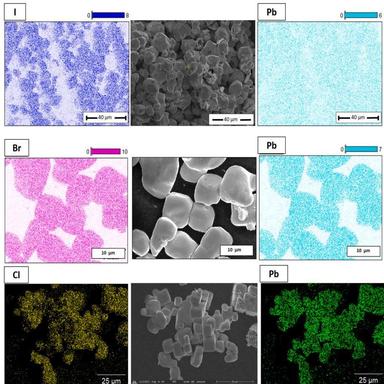
The dark field images of powder perovskites: a) MAPbI3, b) MAPbBr3 and c) MAPbCl3 their EDX mappings of Lead (Pb), Iodine (I) Bromide (Br) and chloride (Cl).